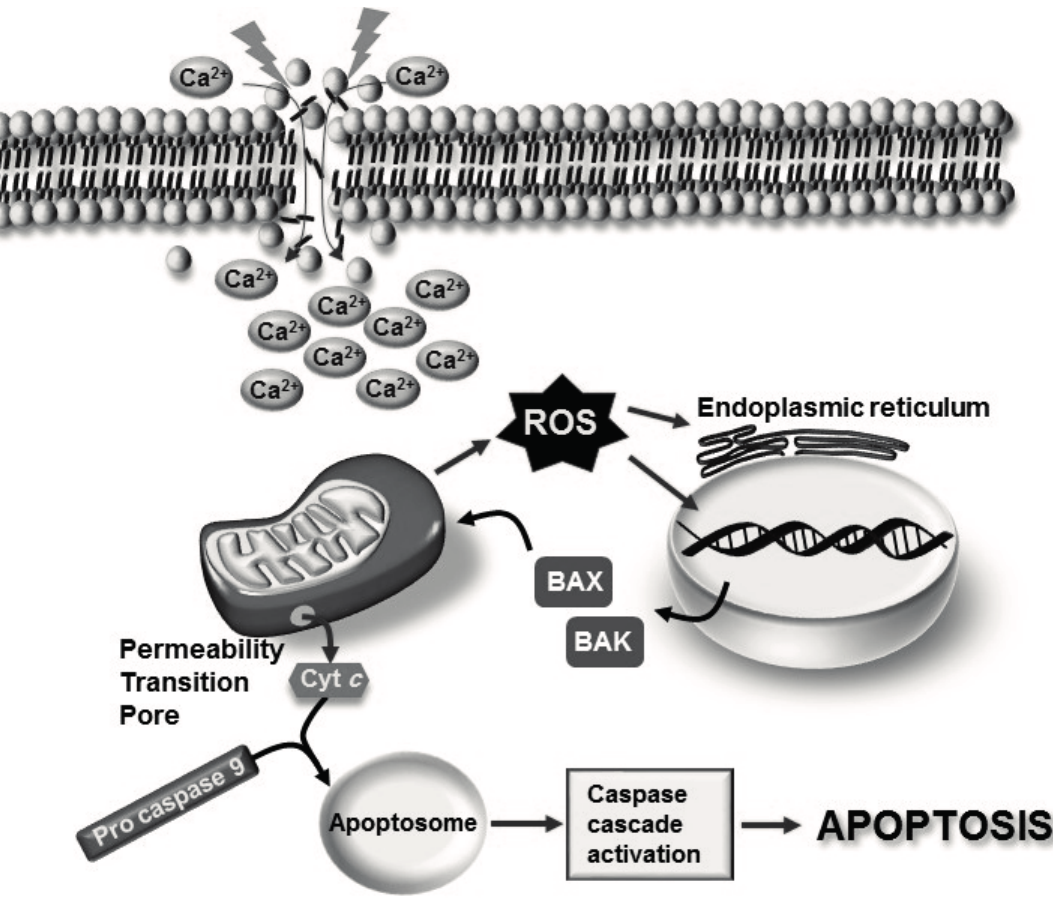
Figure 2. Apoptosis can result from the activation of two biochemical streams known as the extrinsic and intrinsic (mitochondrial) pathways. The intracellular